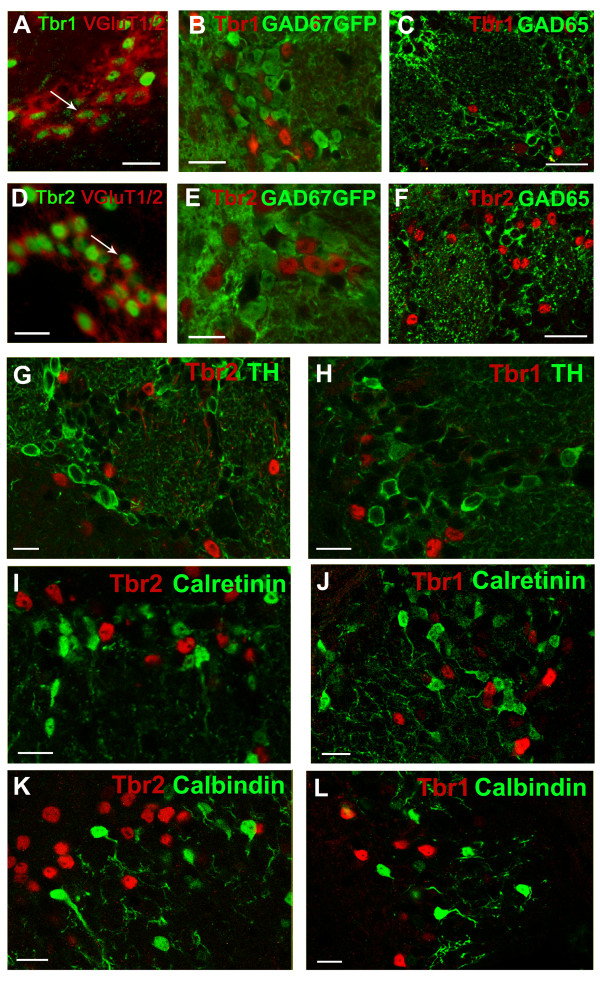
Glutamatergic phenotype of Tbr2- and Tbr1-positive juxtaglomerular OB neurons. (A,D) Tbr2 and Tbr1 are found in VGluT-positive cells, as revealed by combining in situ hybridization for VGluT1/2 (here imported into the red channel) and immunostaining in the green channel. Images are taken from the GL. (B,C,E,F) Tbr2 and Tbr1 do not co-localize with GAD67-GFP (B,E) nor GAD65 (C,F), confirming the non-GABAergic identity of these cell populations. Images are from the GL. (G-L) Tbr2 and Tbr1 do not co-localize with known periglomerular cell markers (TH, CR, CB or parvalbumin) in the GCL. Scale bars: 50 μm in (A-D); 20 μm in (G-R).